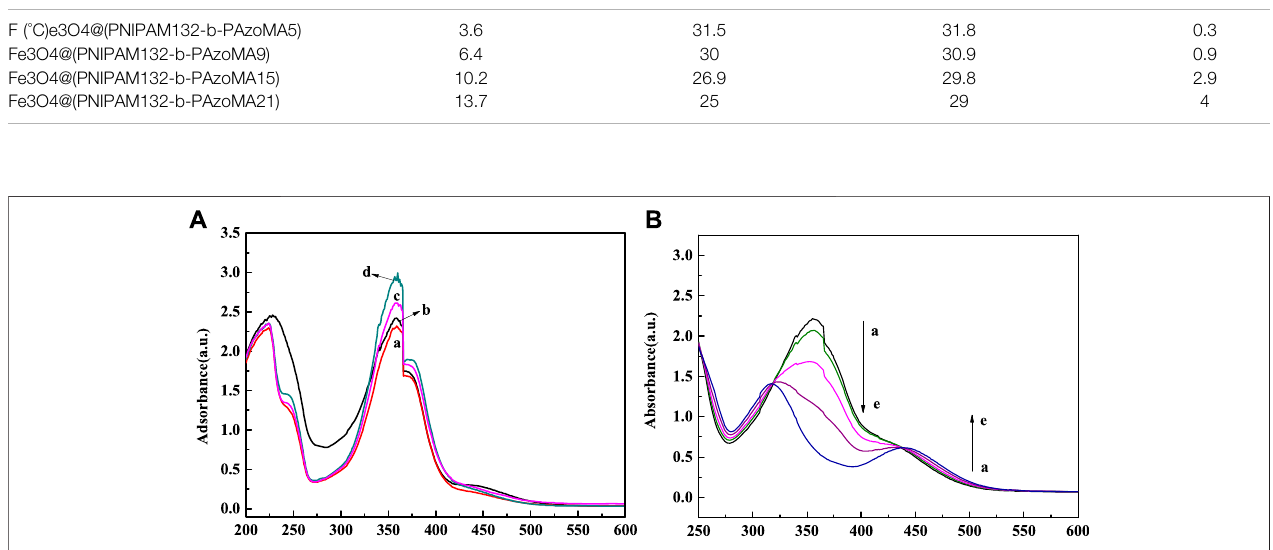
FIGURE 6 | (A) Spectral changes of Fe 3 O 4 @PNIPAM-b-PAzoMA in aqueous solution during UV irradiation (365 nm, 8 W) (a) Fe 3 O 4 @PNIPAM 132 -b-PAzoMA 5 , (b)